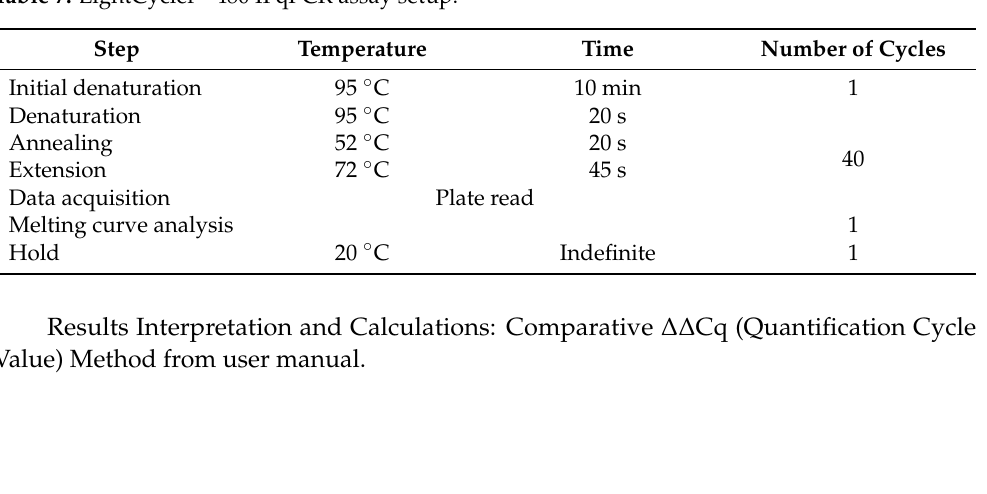
Table 7. LightCycler ® 480 II qPCR assay